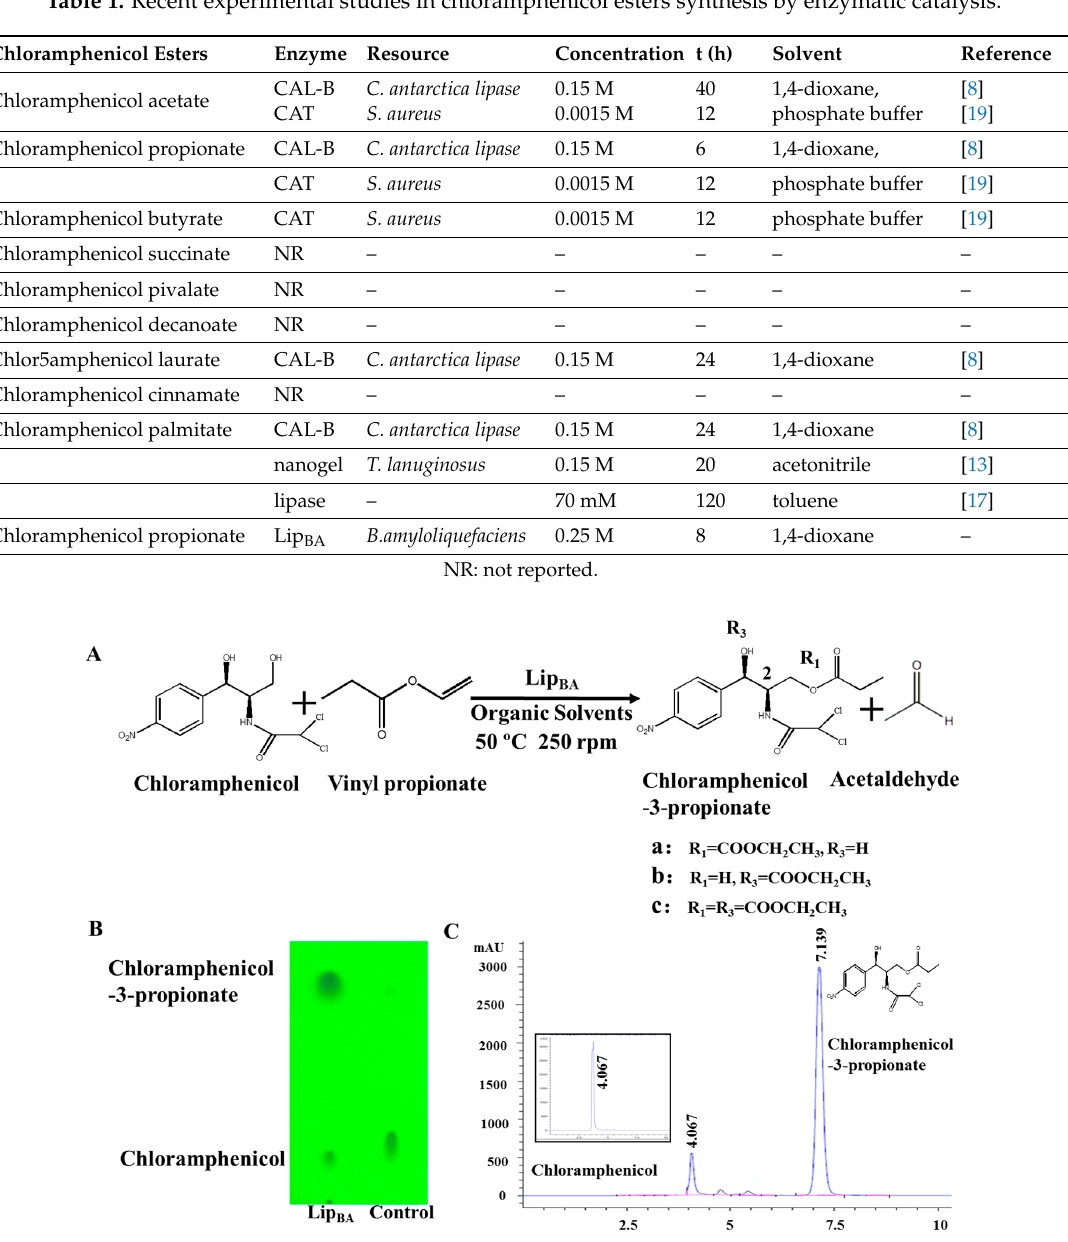
Figure 2. Lipase-mediated esterification of chloramphenicol using vinyl propionate in organic solvents. ( A ) Preparation of chloramphenicol propionate through transesterification; ( B ) TLC analysis of product; ( C ) Chromatogram of chloramphenicol and chloramphenicol-3-propionate. The assay conditions were described in material and methods. Table 1. Recent experimental studies in chloramphenicol esters synthesis by enzymatic catalysis. Chloramphenicol esters